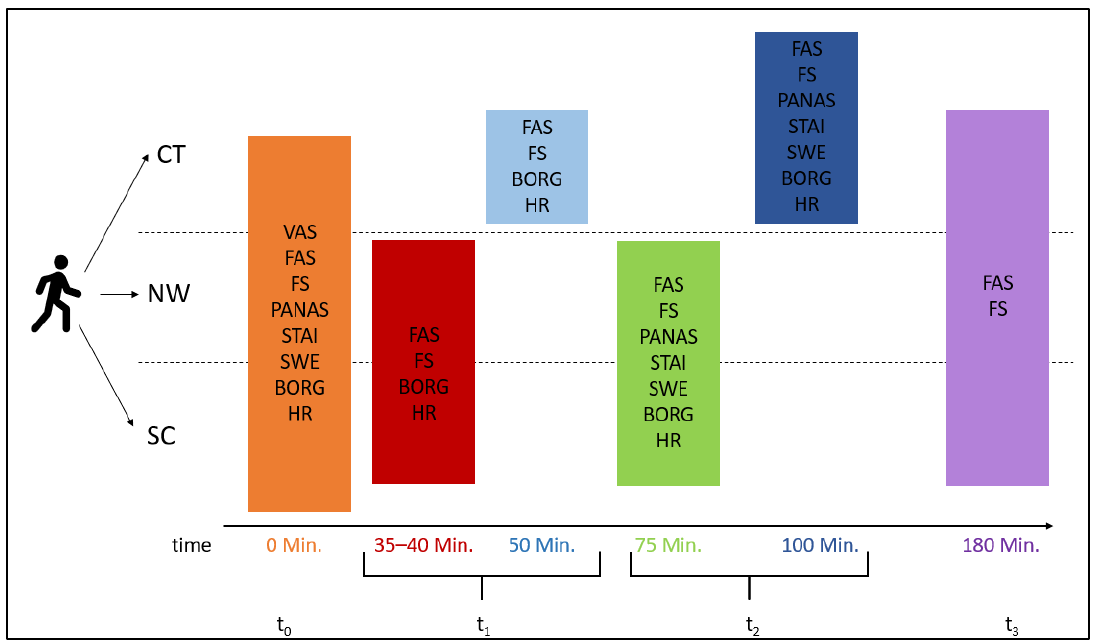
Figure 2. Overview of tests with chronological order before (t 0 ), during (t 1 ), and after (t 2 ) and 180 min after the intervention (t 3 ), subdivided for therapeutic climbing (CT), Nordic walking (NW), and sedentary control condition (SC). Measurement instruments: Visual Analogue Scale (VAS), Felt Arousal Scale (FAS), Feeling Scale (FS), Positive and Negative Affect Schedule (PANAS), State-Trait Anxiety Inventory (STAI), General Self-Efficacy Scale (SWE), Borg Scale (BORG), and heart rate (HR).